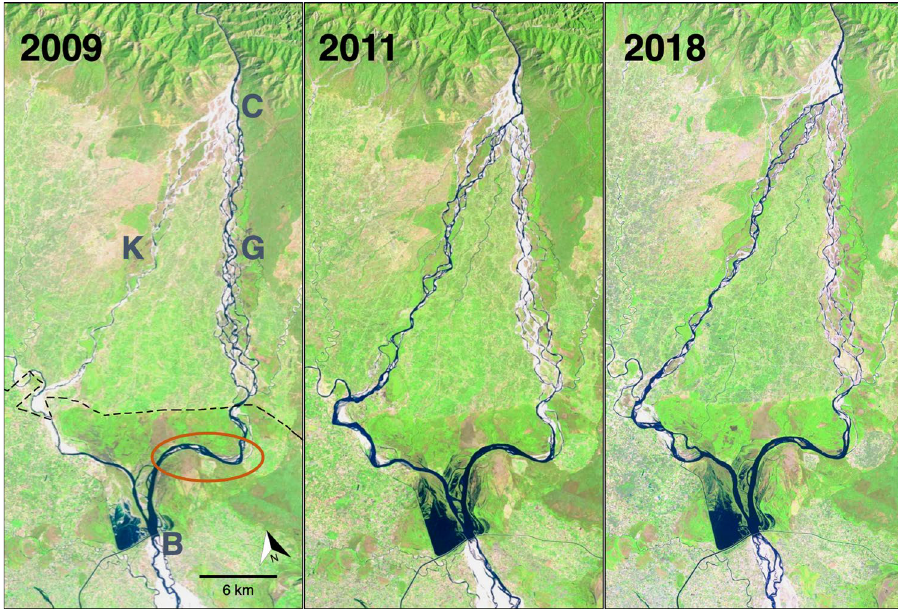
Figure 1. Satellite images before (2009; left panel) and after (2011 and 2018; middle and right panels) a flood event in 2010 in Karnali river channels, Nepal. The flood resulted in a mainstream channel shift from east (right side, = G, Geruwa channel in Nepal) to west (left side, = K, Karnali channel in Nepal). The Karnali mainstream naturally bifurcates below Chisapani (= C, above channel split) into two channels that flow into India across the international border (dashed line), forming the Kaudiyala (west branch) and Girwa (east branch) rivers. The reservoir created by the Girijapuri barrage (B = dam, barrage) maintained sufficient water level to support a breeding gharial population in a 10 km stretch of the Girwa (enclosed in orange oval). The barrage has control gates which allow water to flow downstream, but obstruct the movements of gharial upstream. Image source: Landsat series 4–5,7 (LandsatLook Natural Color Image, landsat 4–5 tm c1 level-1 and landsat 7 ETM + c1 level- 1). Maps were generated from freely available satellite image data of U. S. Geological Survey (https ://www.usgs.